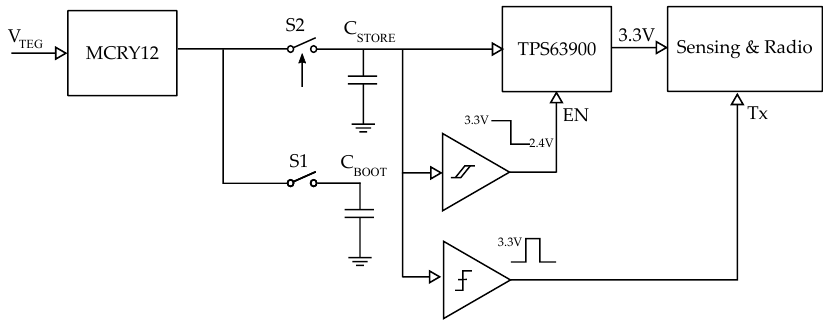
Figure 7. Block diagram of the energy harvester power management